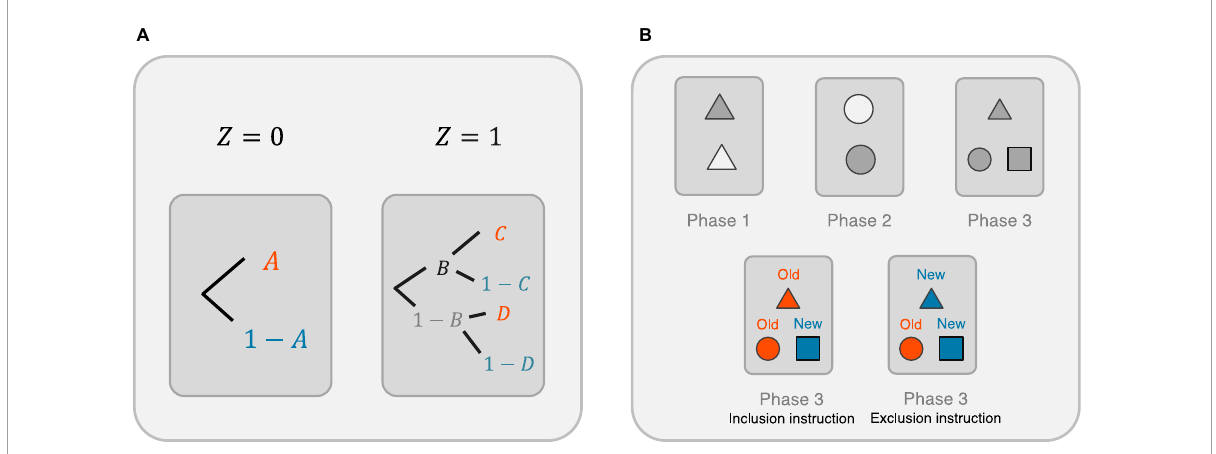
FIGURE3 Linking the potential outcomes-based priming research with two prominent quantitative psychological methods. (A) Multinomial processing tree (MPT) model for studying the priming effect. Here, A and 1 − A are the probabilities of correctly and incorrectly, respectively, identifying the words without a word study (i.e., given Z = 0); B and 1 − B are the probabilities of storing (consciously or unconsciously) and not storing, respectively, the studied word after a word study (i.e., given Z = 1); C and 1 − C are the probabilities of correctly and incorrectly, respectively, identifying the words if the studied words are stored in the memory; D and 1 − D are the probabilities of correctly and incorrectly, respectively, identifying the words if the studied words are not stored in the memory. (B) A three-phase experiment with exclusion and inclusion instructional conditions. Top left: A set of items is shown during the Phase 1 study. Top middle: Another set of items (different from those in Phase 1) is shown during Phase 2. Top right: During Phase 3, the participants are given a list of items consisting of those who have appeared during Phases 1 and 2 and distractor items that have not appeared before. Subsequently, they are asked to classify them into either “old” or “new” following an inclusion instruction or an exclusion instruction. Bottom left: Under the inclusion instruction, participants need to call an item old if it has appeared in either Phase 1 or 2 and call a distractor item new. Bottom right: Under the exclusion instruction, participants need to call an item old only if it has appeared in Phase 2, and new